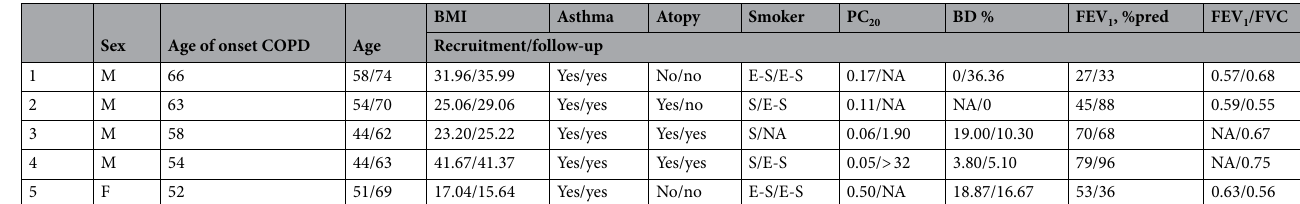
Table 4. Changes in the respiratory status of the five participants who developed a chronic obstructive pulmonary disease between recruitment and follow-up evaluation. BMI body mass index (kg/m 2 ), BD bronchodilator response, COPD chronic obstructive pulmonary disease, E-S ex-smoker, FEV 1 forced expiratory volume in 1 s, FVC forced vital capacity, N-S non-smoker, NA not available, PC 20 provocative concentration for a 20% decrease in FEV 1 , S